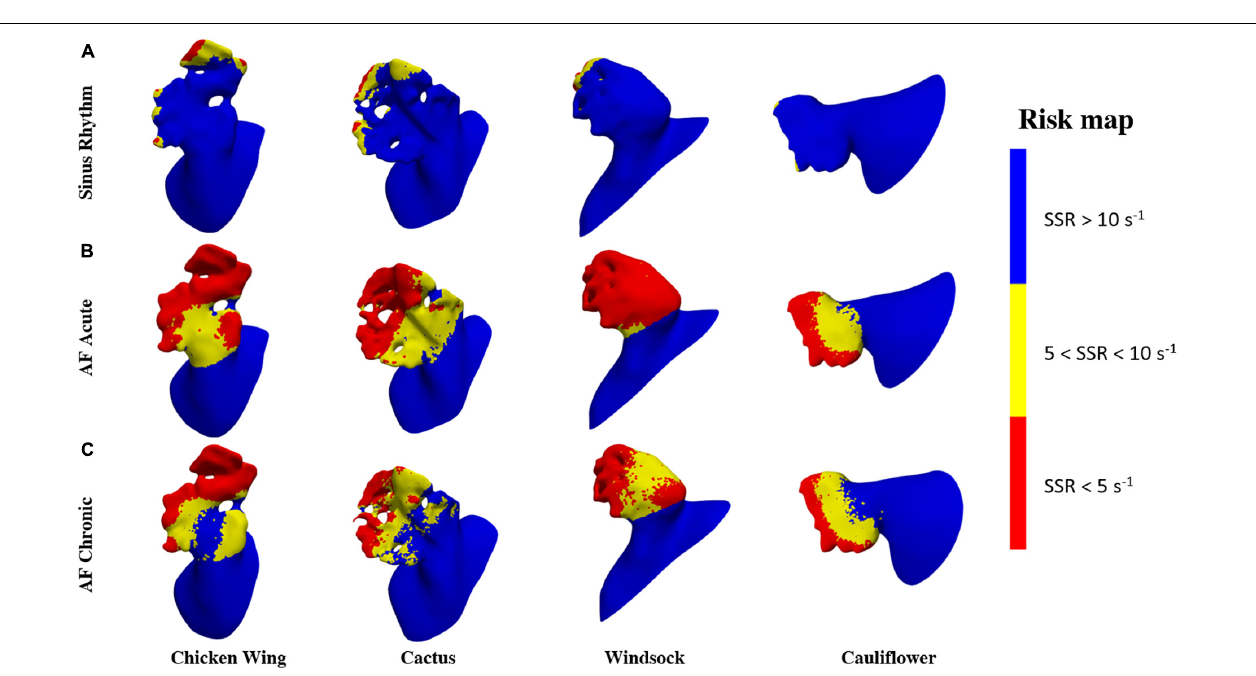
Figure 7 . These thresholds were selected to better identify the regions of low and very low persistent shear rates, where red blood cell aggregation is expected to be more pronounced with a consequent increase in viscosity (in the real case) and clotting (43).